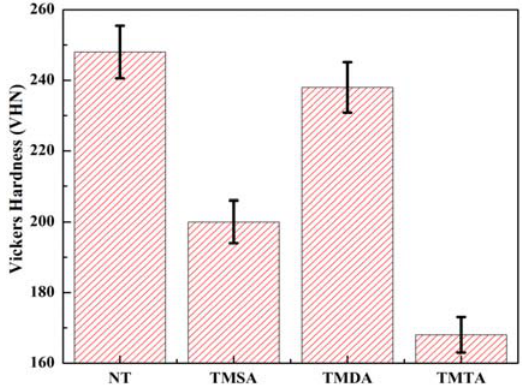
Figure 6. Plot of micro Vickers hardness values of non-treated and TMCA treated AISI 1345 steel.